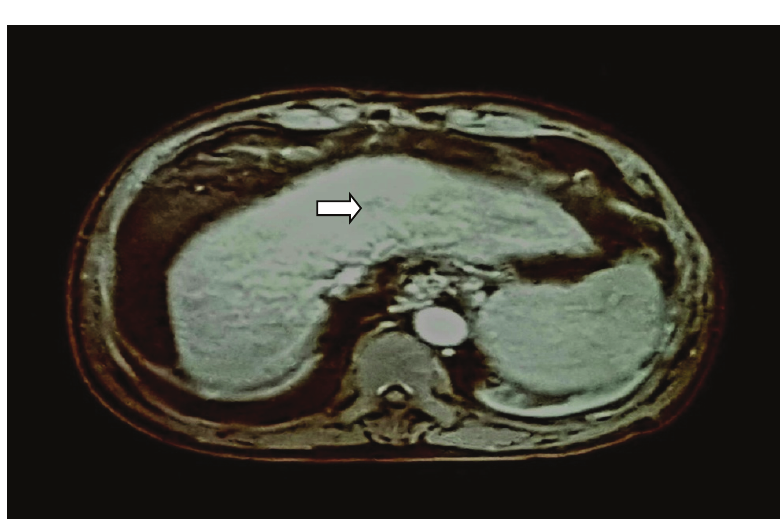
Figure 2: MRI image of small HCC nodule in hepatic